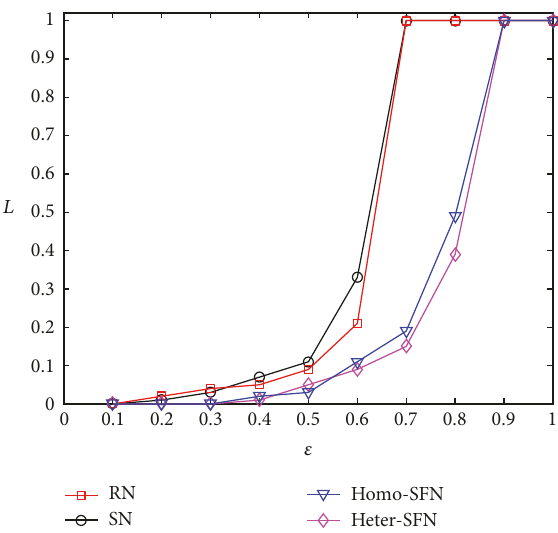
Figure 11: 𝐿 - 𝜀 relation curve under random attack (𝑅 = 1)